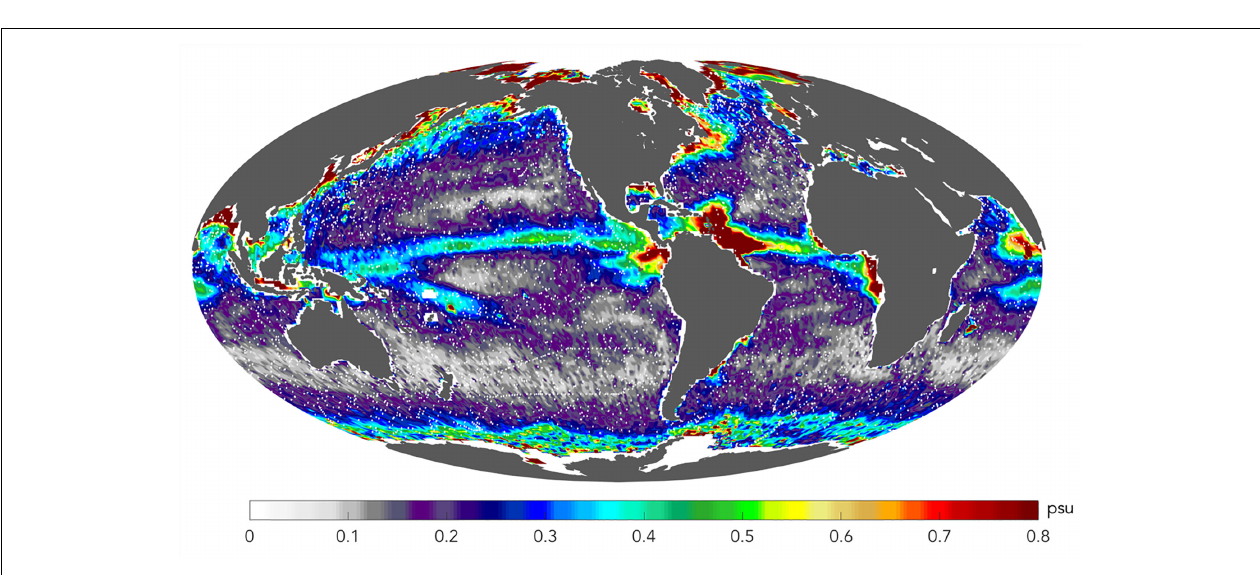
FIGURE 2 | Variability in space-borne sea surface salinity during 1 year (colors) superimposed with locations of currently operational Argo floats (white dots). Notice that regions of high variability of > 0.2 are either not sampled or poorly sampled by Argo, including coastal oceans, western boundary currents, the Indonesian Seas, outlets of major rivers (Amazon, Niger, and Congo), as well as the Southern and Arctic